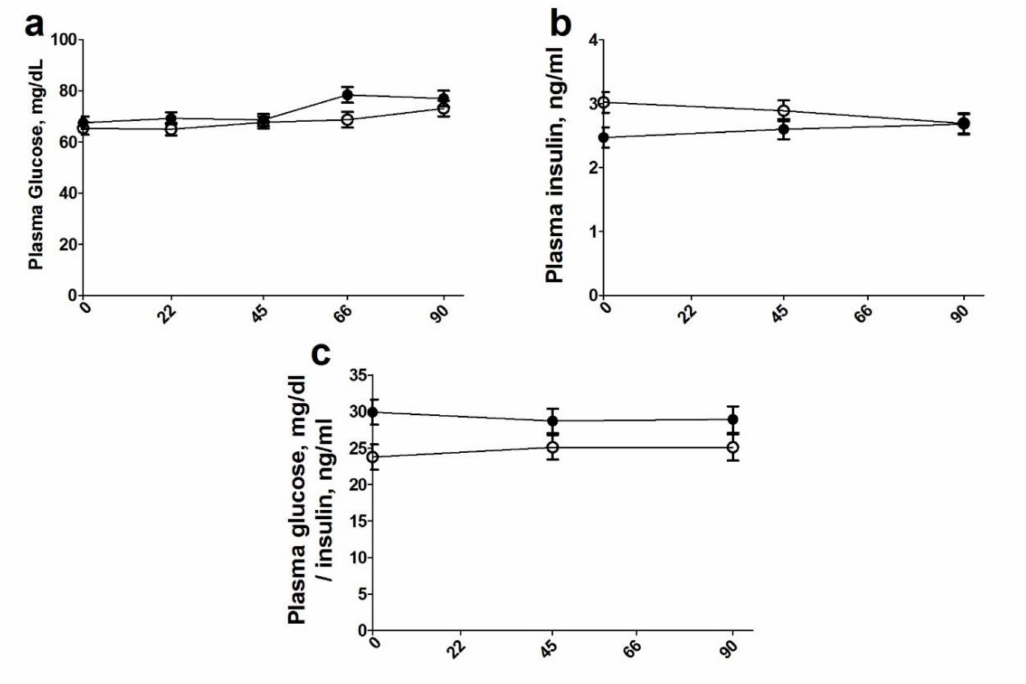
Figure 2. Plasma glucose ( a ) and insulin ( b ) concentrations as well as glucose to insulin ratios ( c ) on d 0, 22, 45, 66, and 90 ( y axis) of the treatment for steers individually supplemented an isocaloric, isonitrogenous diet with no rumen by-pass lipid (CON; n = 24; open circle) or with a rumen by-pass lipid (Essentiom ™ ; RBL; n = 24; closed circle) daily. Values are presented as ± SEM (glucose treatment: p = 0.03; day: p = 0.004. Insulin treatment: p = 0.02. Glucose to insulin ratio: treatment: p =